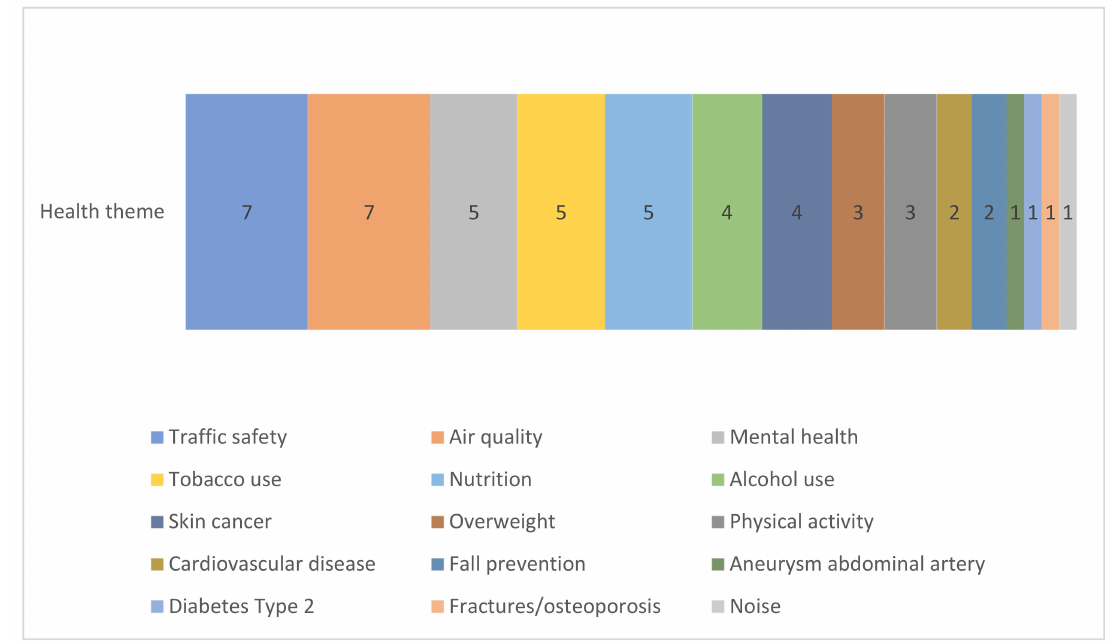
Figure 1. Types of health themes in the 51 interventions.